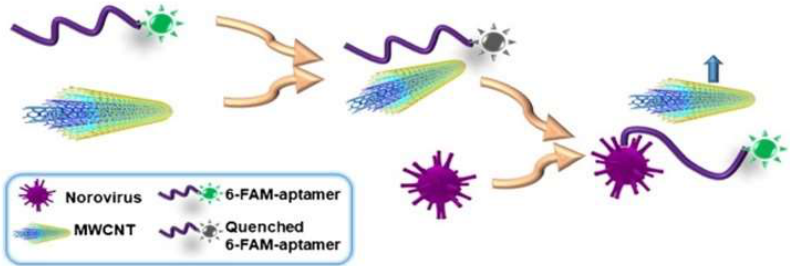
Figure 8. Schematic illustration of “signal-on” aptasensor based on MWCNT and fluorescence-labeled aptamer. Reproduced with permission from reference [92]. Copyright 2017 Springer.